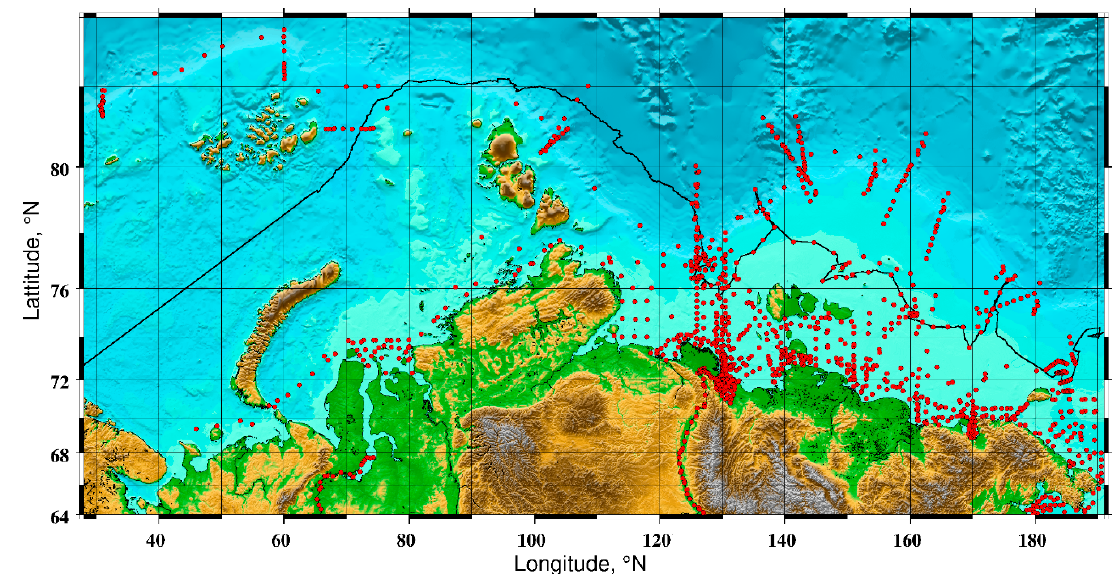
Figure 9. Distribution of oceanographic stations conducted over the ESAS from 1999–2017. Oceanographic stations performed by the authors (n > 2700) are shown as red dots; the ship’s track of IB Oden (2014) is shown as a solid black line; oceanographic stations performed by the cruise participants onboard IB Oden (leg 1, n = 67) are shown as red dots superimposed on the black line.